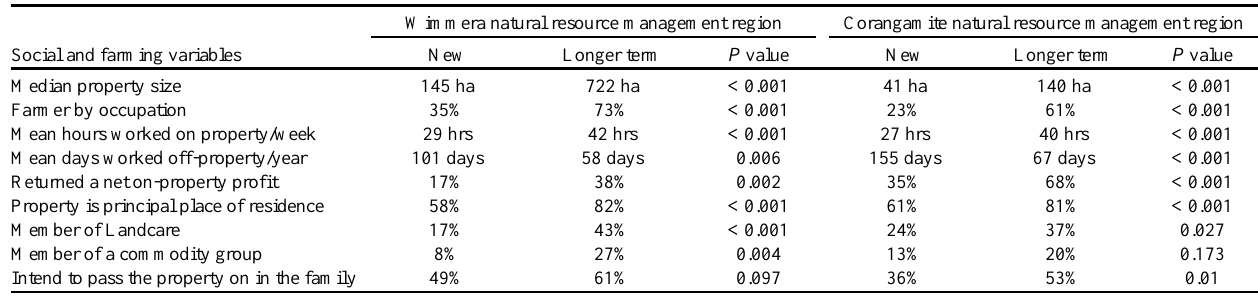
Table 2 . Comparing newer (Wimmera region: n = 55–73; Corangamite region: n = 83–91) and longer term (Wimmera region: n = 311–404; Corangamite region: n = 311–404) landholders: social and farming variables.( n denotes the number of respondents. Each item had a different number of respondents owing to missing values; these are indicated by the ranges in n